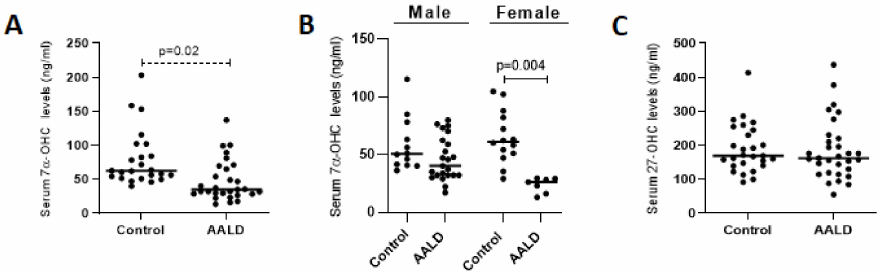
Figure 9. Serum concentrations of 7 α -OHC ( A ), 7 α -OHC stratified for sex ( B ), and 27-OHC ( C ), as measured by GC-MS-SIM. (AALD, n = 31, 24 men, 7 women, and controls, n = 27, 14 men, 13 women). AALD, alcohol-associated liver disease. p < 0.05 was considered significant.